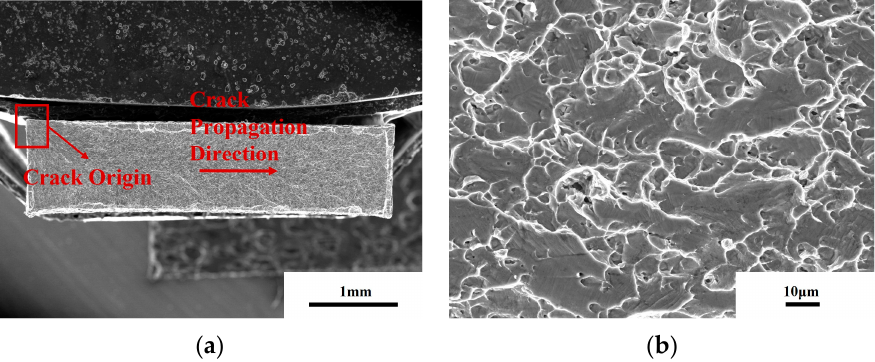
Figure 13. Fracture morphology after tensile test of alloy annealed at 800 °C for 60 min. ( a ) Low magni fi cation morphology of fracture area; and ( b ) dimple region.